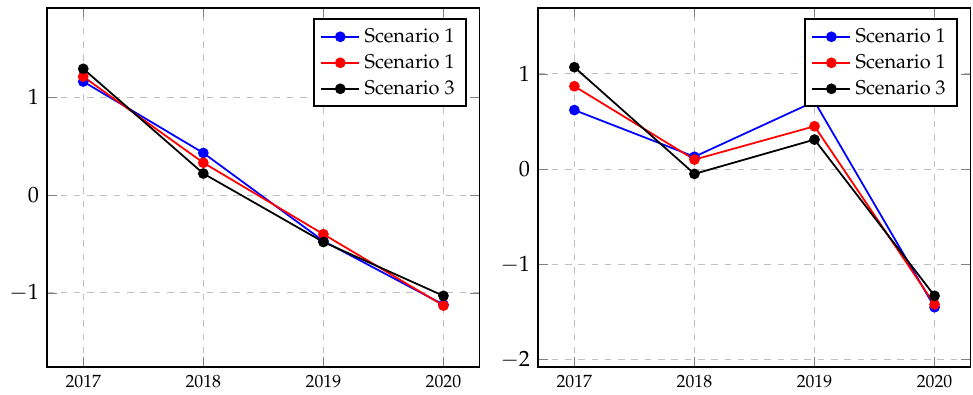
Figure 9. ( Left ): Evolution of the SAIDI Indicator for the multiple scenarios presented. ( Right ): Evolution of the SAIFI Indicator for the multiple configuration scenarios presented. Each of the presented scenarios represents an obtained